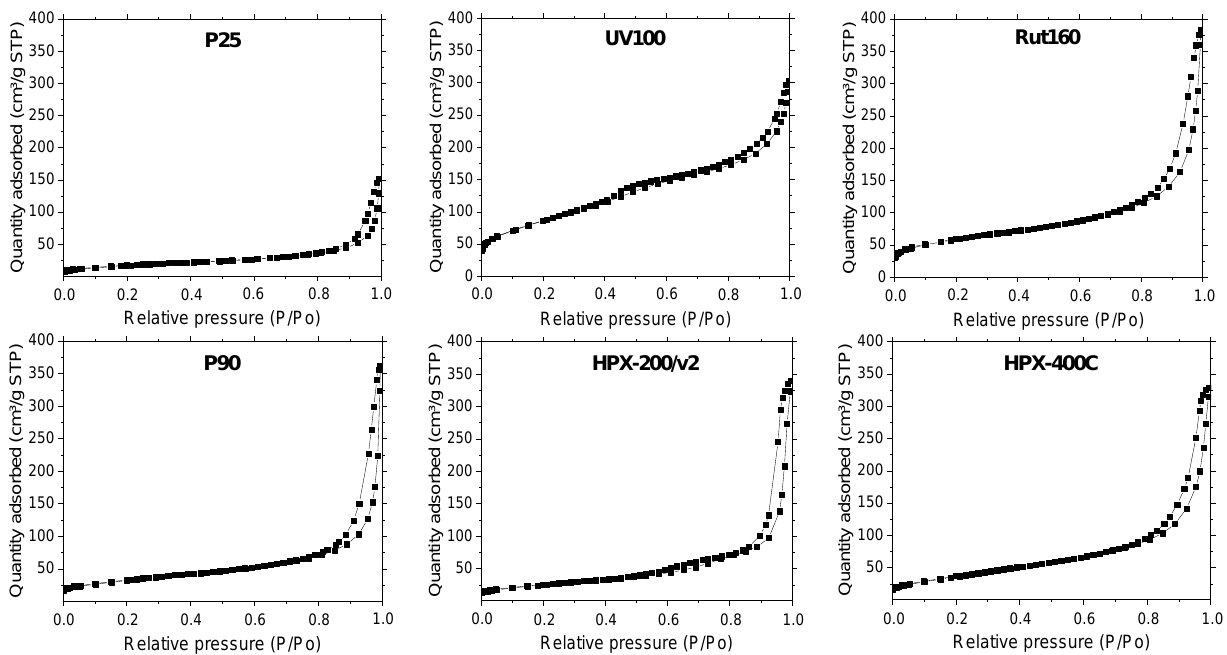
Figure 2. N 2 adsorption/desorption isotherm of the commercial TiO 2 samples. Catalyst pretreatment: 300 °C for 2 h under vacuum (heating rate: 5 °C.mn − 1 ) .